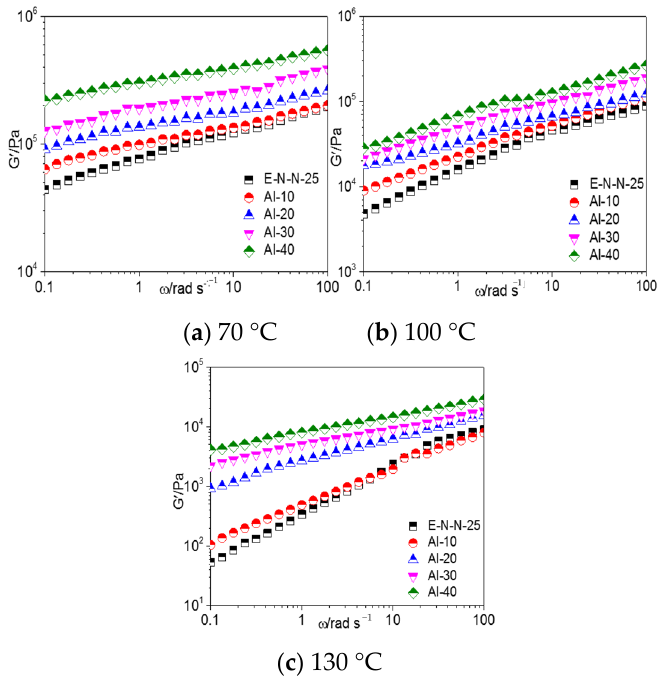
Figure 3. G ′ – ω curves of model propellants with different Al powder